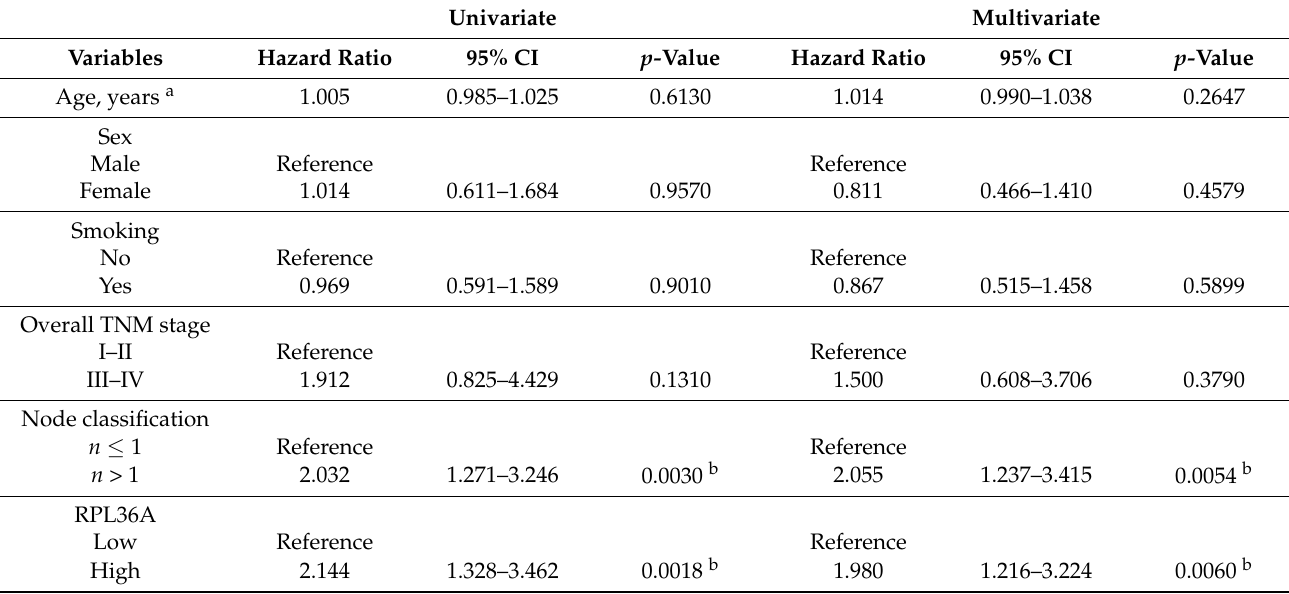
Table 2. Results of univariate and multivariate analyses of disease-specific survival of 147 OSCC patients with radiotherapy from the TCGA